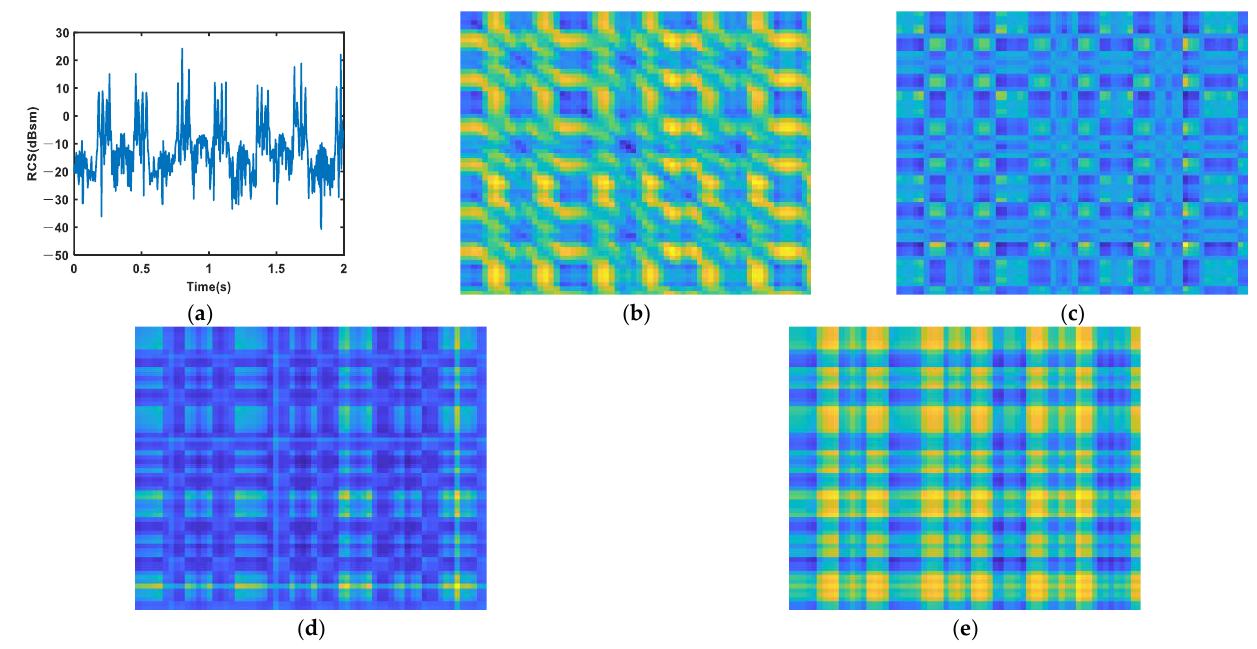
Figure 7. ( a ) RCS; ( b ) RP; ( c ) MTF ; ( d ) GASF; ( e ) GADF . RCS sequences encoding of the booster.